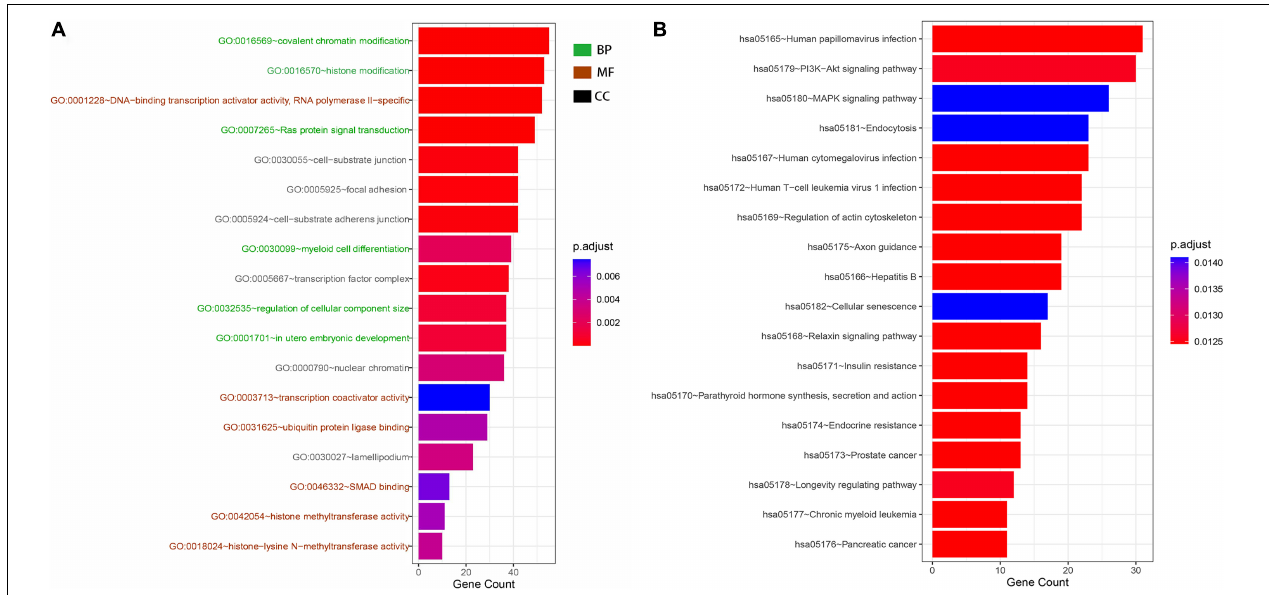
FIGURE 6 | Gene Ontology (GO) and Kyoto Encyclopedia of Genes and Genome (KEGG) functional annotation. (A) GO functional annotation of target genes. Green shows the six biological processes (BP) in which target genes are involved, brick red shows the six molecular functions (MF) of the target genes, and black shows the six cellular components (CC) of the target genes. (B) KEGG functional annotation of target genes. Each row shows a signaling pathway in which the hsa_circ_0012152 target genes may be